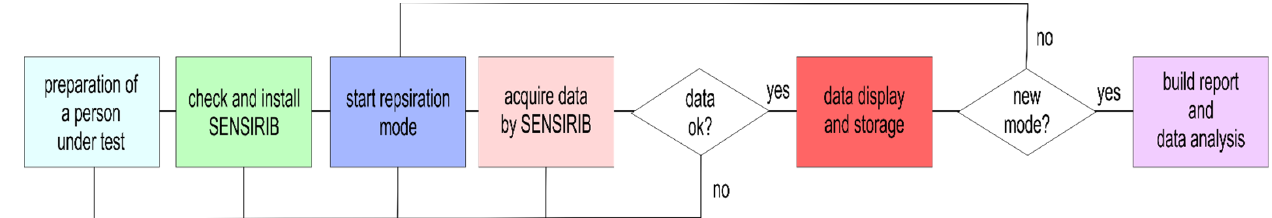
Figure 4. A flowchart for the framework and operation of testing respiration by using SENSIRIB.